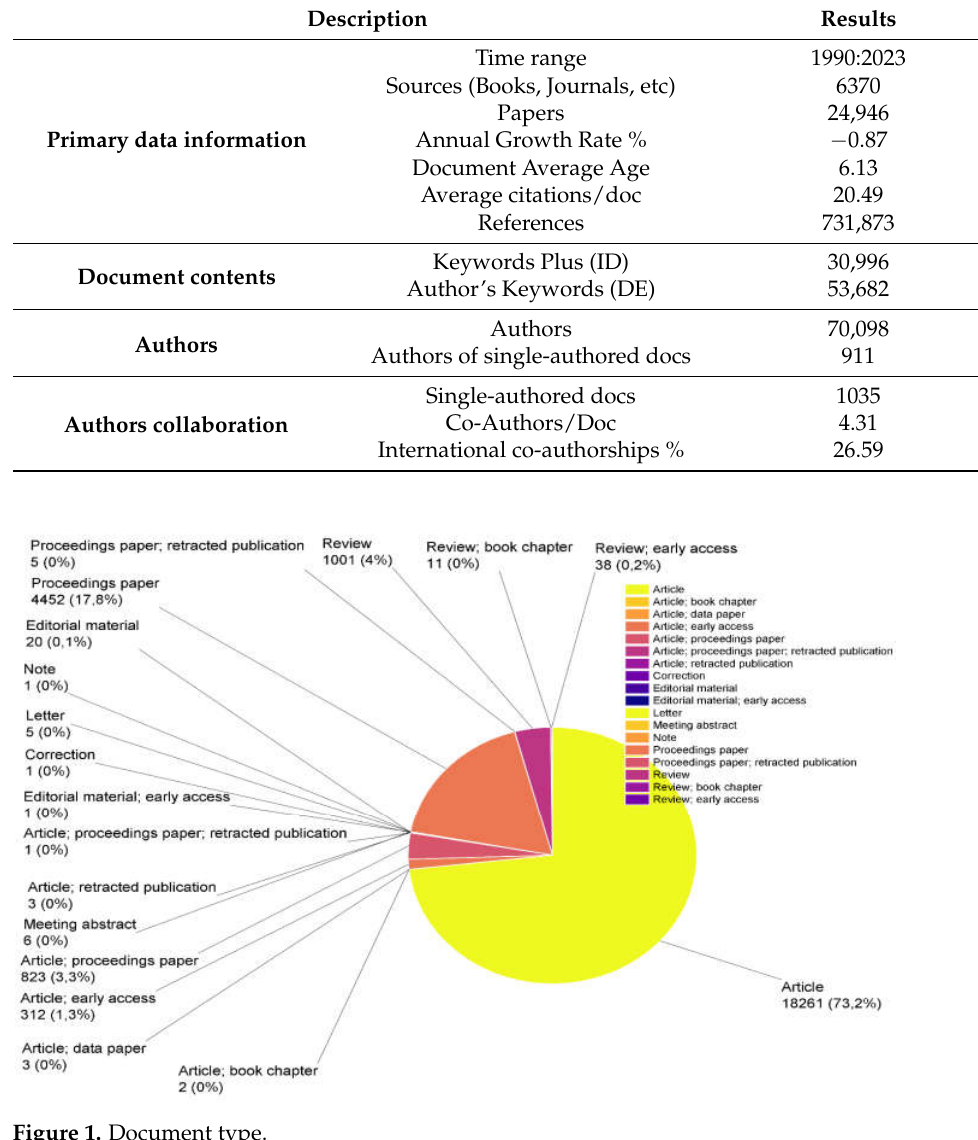
Figure 1. Document type.